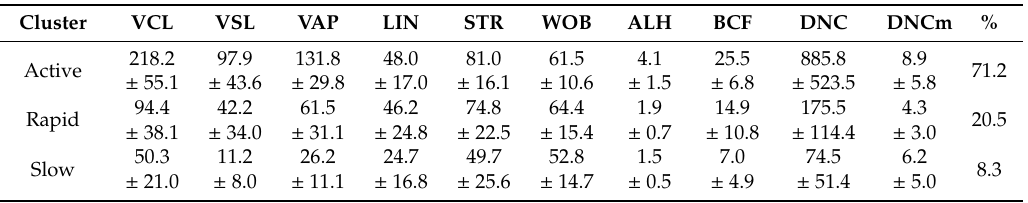
Figure 5. Effects of incubating bull spermatozoa with different melatonin concentrations on motility parameters (CASA analysis; Control, no melatonin, as reference). Plots show mean ± SEM for each concentration in the two in the absence (no capacitating) or presence (capacitating) of heparin (variable names expanded in Figure 1). Asterisks label melatonin effects significantly different from the Control (* p < 0.05, ** p < 0.01). Table 1. Descriptive statistics of each sperm cluster obtained after the sperm subpopulation analysis from CASA data. Clusters are described by the median ± SD of the CASA variables, including the overall proportion (all data pooled). VCL: Curvilinear velocity; VSL: Straight path velocity; VAP: Average path velocity according to the average smoothed path; µm/s; LIN: Linearity; STR: Straightness; WOB: wobble; ALH: amplitude of the lateral displacement of the sperm head; BCF: Frequency of the flagellar beat; DNC: Sperm dance; DNCm: Sperm mean dance.